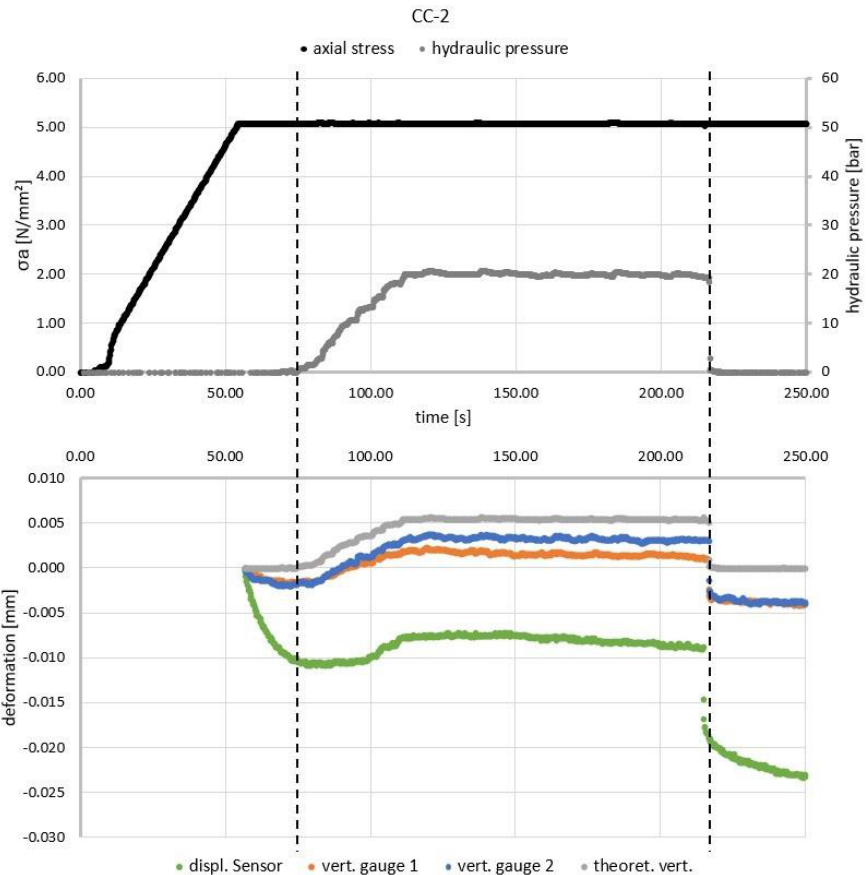
Figure 11. Sequential loading for test CC − 2 and vertical deformations calculated from measured strain (strain gauges), measured displacement (inductive displacement sensor) and theoretical deformations ( E c = 22,000 MPa, ν = 0.2 ).